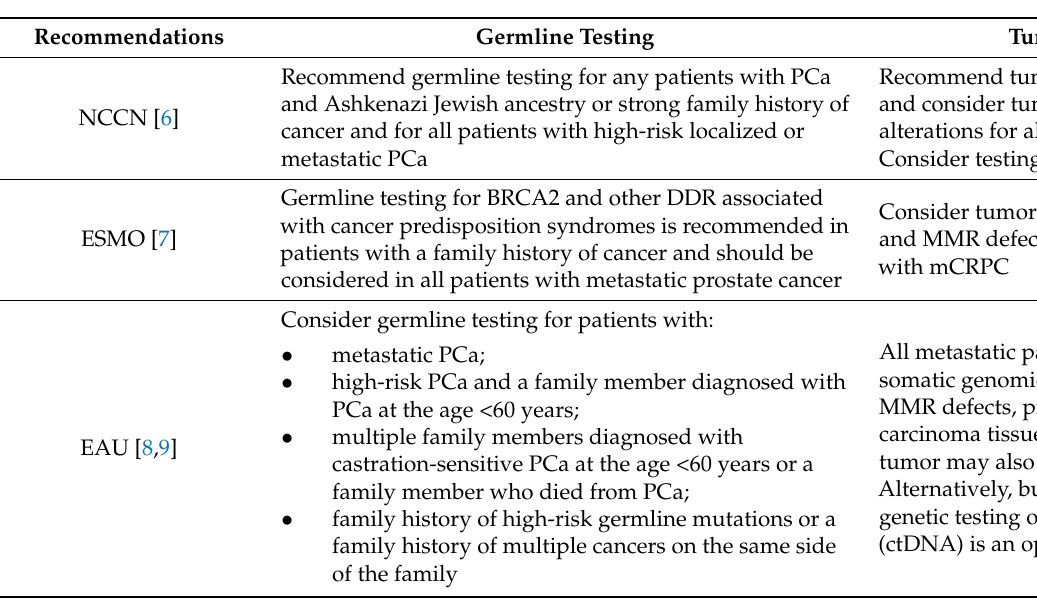
Table 1. Recommendations for germline and somatic genomic testing in advanced